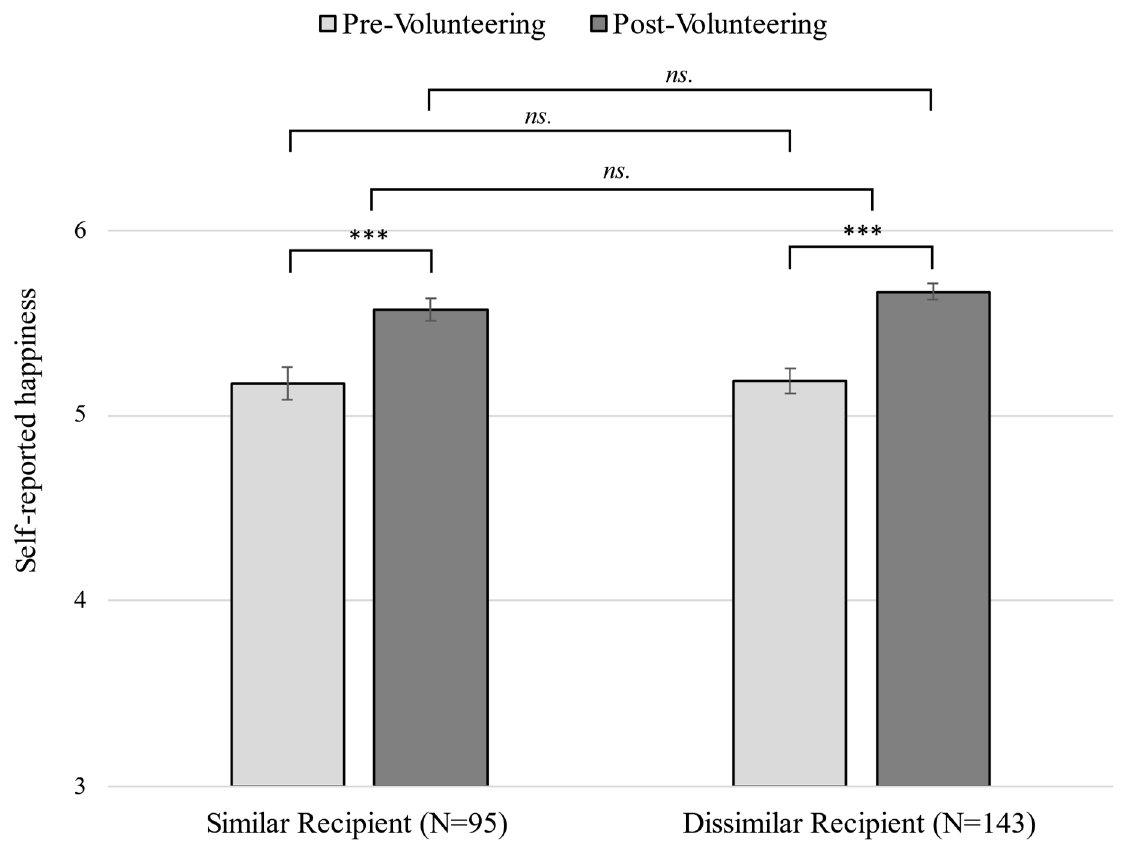
Figure 2. Self-reported happiness before and after packaging items for similar or dissimilar children at the Cradles to Crayons (C2C) Giving Factory. *** p < 0.001; ns = non-significant. Error bars represent standard errors.